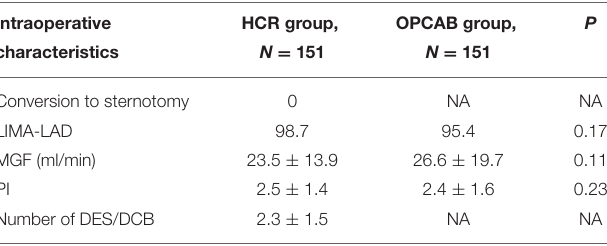
TABLE 3 | Intraoperative characteristics of matched patients who underwent HCR and OPCAB.